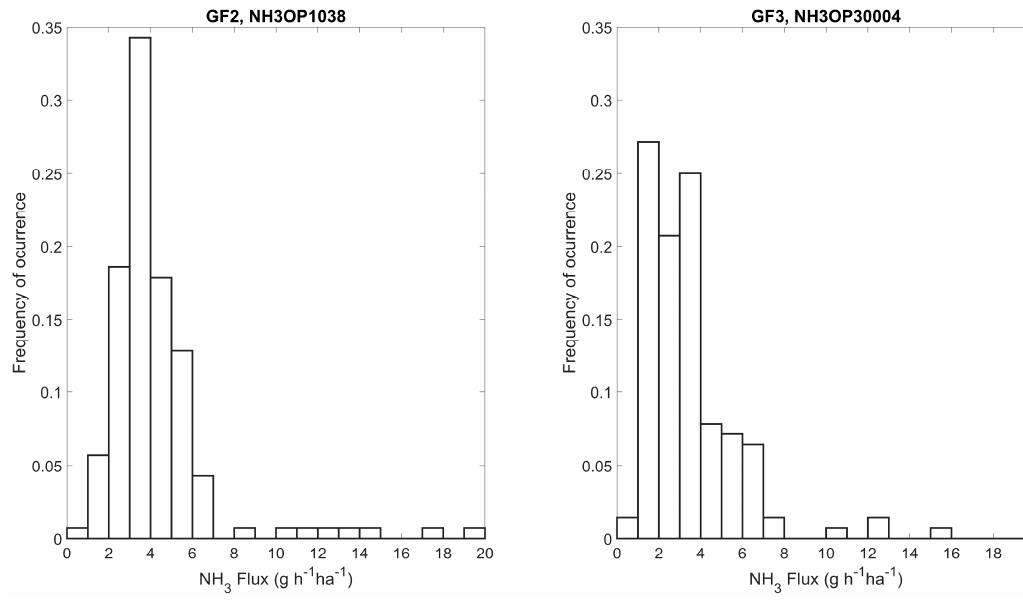
Figure 8. Histograms of NH 3 flux measured by the two lasers.